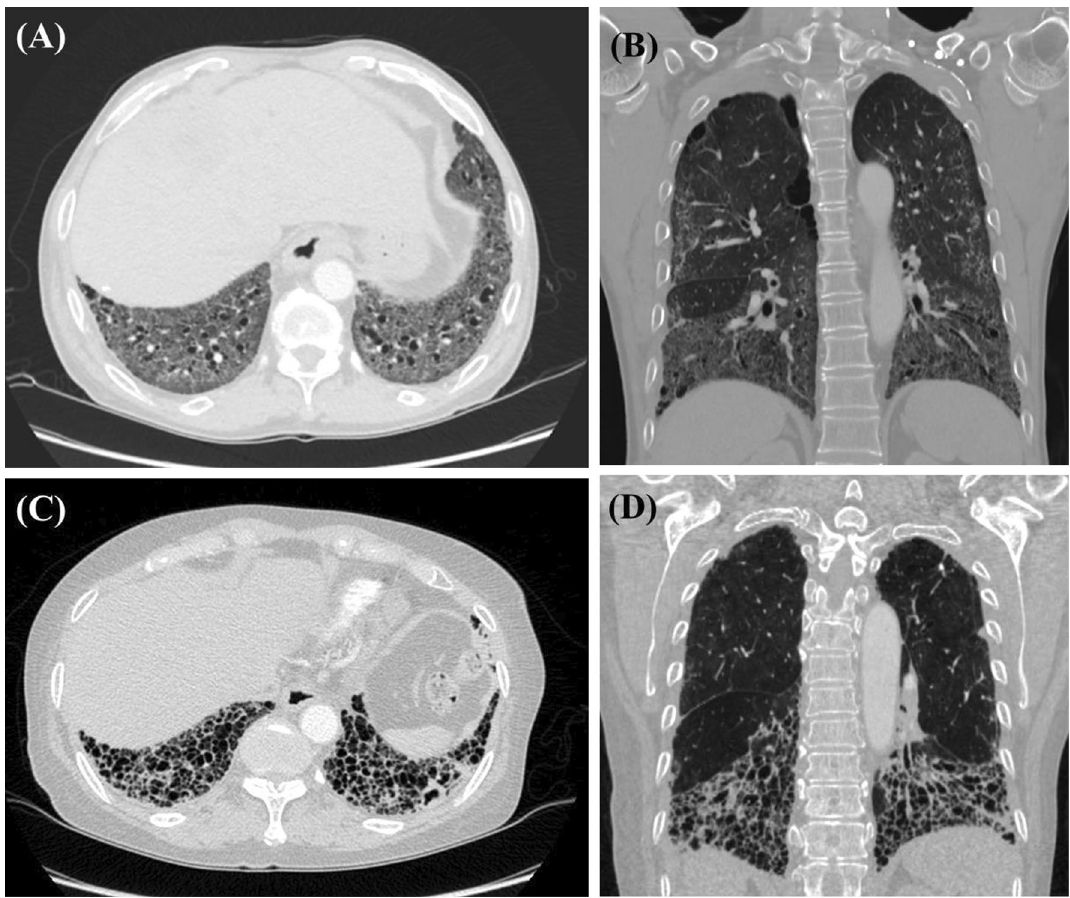
Figure 1. Representative HRCT images of patients with SSc-ILD. Axial ( A ) and coronal ( B ) HRCT images of an anti-CCP antibody-negative patient with SSc-ILD. They show extensive ground-glass opacities and traction bronchiectasis with basal predominance. These findings are typical of a non-specific interstitial pneumonia pattern. Axial ( C ) and coronal ( D ) HRCT images of an anti-CCP antibody-positive patient with SSc-ILD. They show predominant lower lobe pulmonary fibrosis and traction bronchiectasis with exuberant honeycombing sign. These findings are consistent with the usual interstitial pneumonia pattern. HRCT: high resolution computed tomography; SSc: systemic sclerosis; ILD: interstitial lung disease.